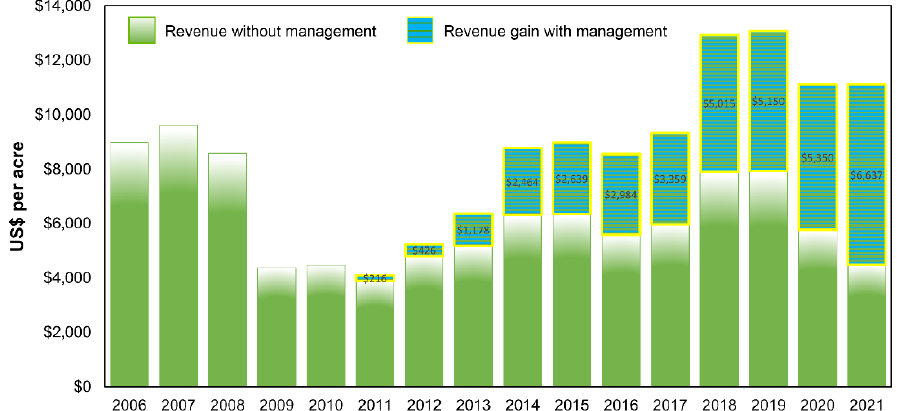
Figure 5. Average revenue (USD per acre) for Hawaii-grown coffee without CBB management from 2006 to 2021 and gain in revenue due to all combined CBB management beginning in 2011.